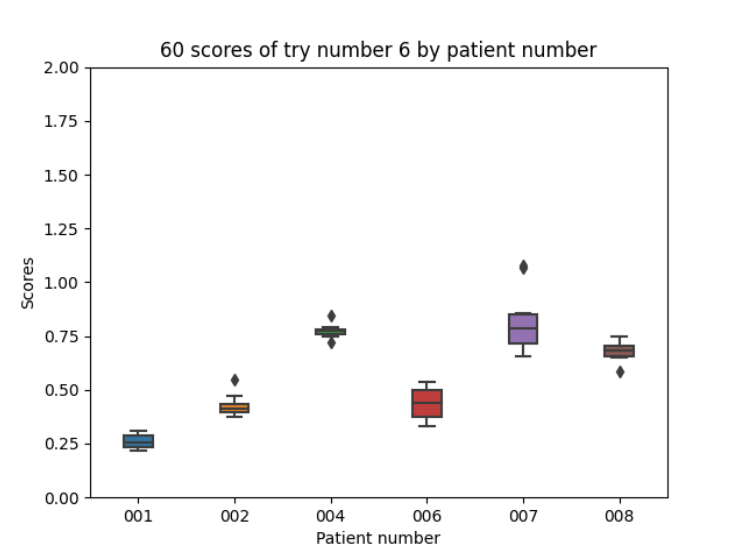
Figure 17. Experiment 6 boxplot scores, from 10 executions for each patient and